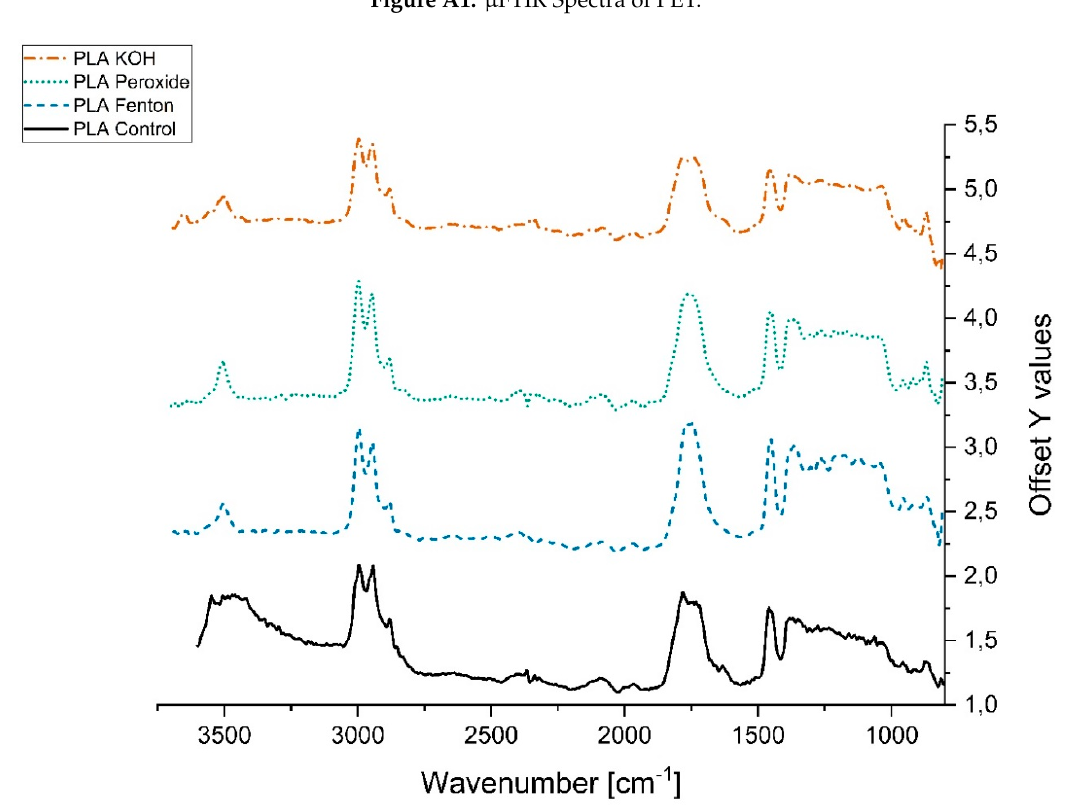
Figure A1. µ FTIR Spectra of PET. Figure A1. µFTIR Spectra of PET. Figure A1. µFTIR Spectra of PET.